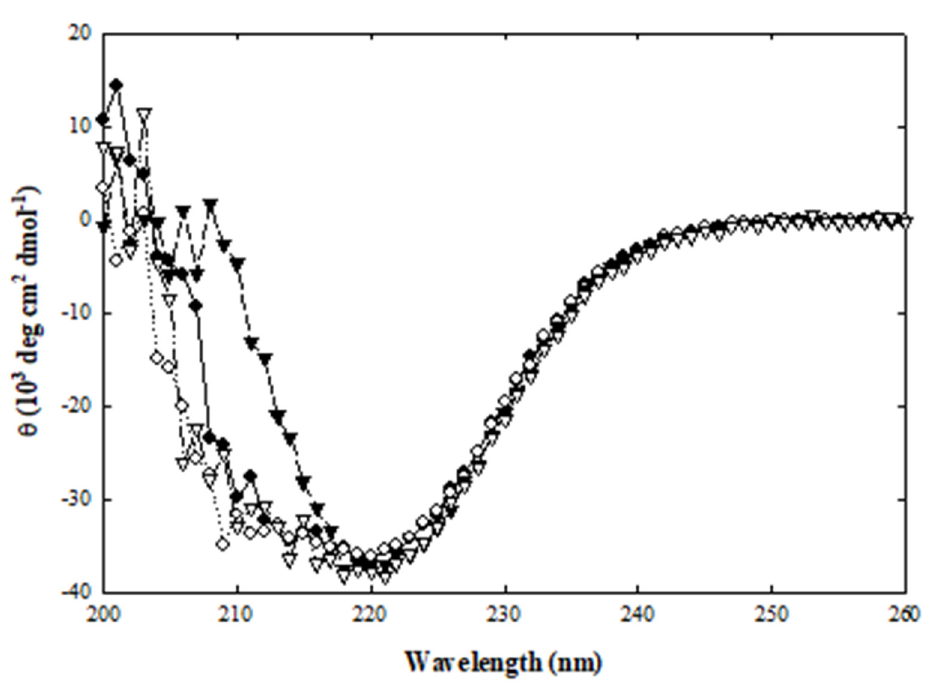
Figure 5. The far-UV CD spectroscopy of the HCV NS3 antigen recorded at 25 °C. These recombinant NS3 antigens include fresh 37 °C produced ( ● ), fresh 25 °C produced ( ο ), long-term- NS3 antigens include fresh 37 ◦ C produced ( • ), fresh 25 ◦ C produced (o), long-term-stored 37 ◦ C stored 37 °C produced ( ▼ ), and long-term-stored 25 °C produced ( ∇ ) protein samples. produced ( (cid:72) ), and long-term-stored 25 ◦ C produced ( ∇ ) protein